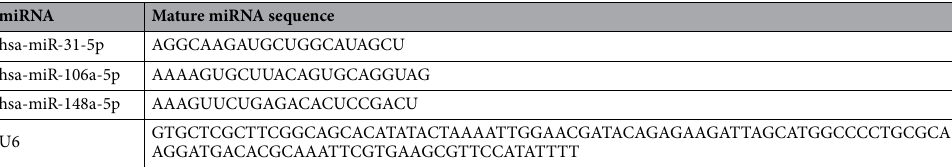
Table 1. The mature miRNA